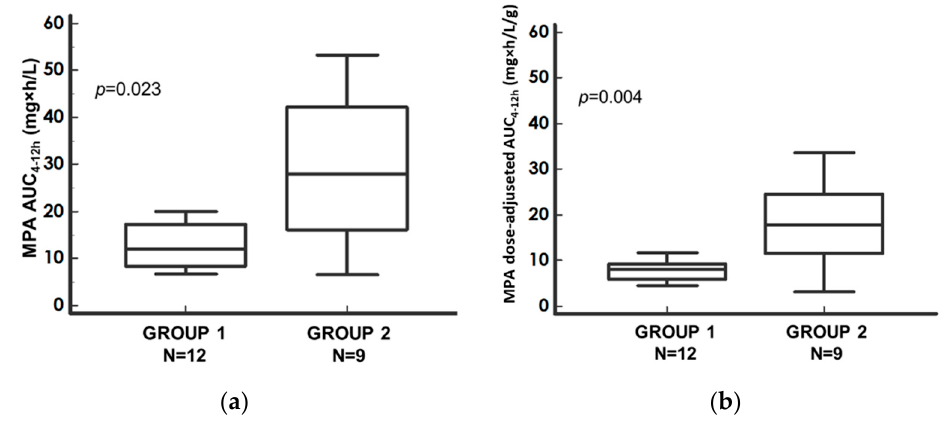
Figure 2. Comparison of ( a ) MPA–AUC 4–12h ; ( b ) dose-adjusted MPA–AUC 4–12h; between Group 1 (MMF + CsA group) and Group 2 (MMF + TAC group) and corresponding p -value of the Mann– Whitney test. Median values with the corresponding 95% confidence intervals (bars). Dots represent the outliers. Nomenclature: AUC 4–12h —area under the 4–12-h concentration–time curve; CsA— cyclosporine MPA—mycophenolic acid; MMF—mycophenolate mofetil; TAC—tacrolimus.